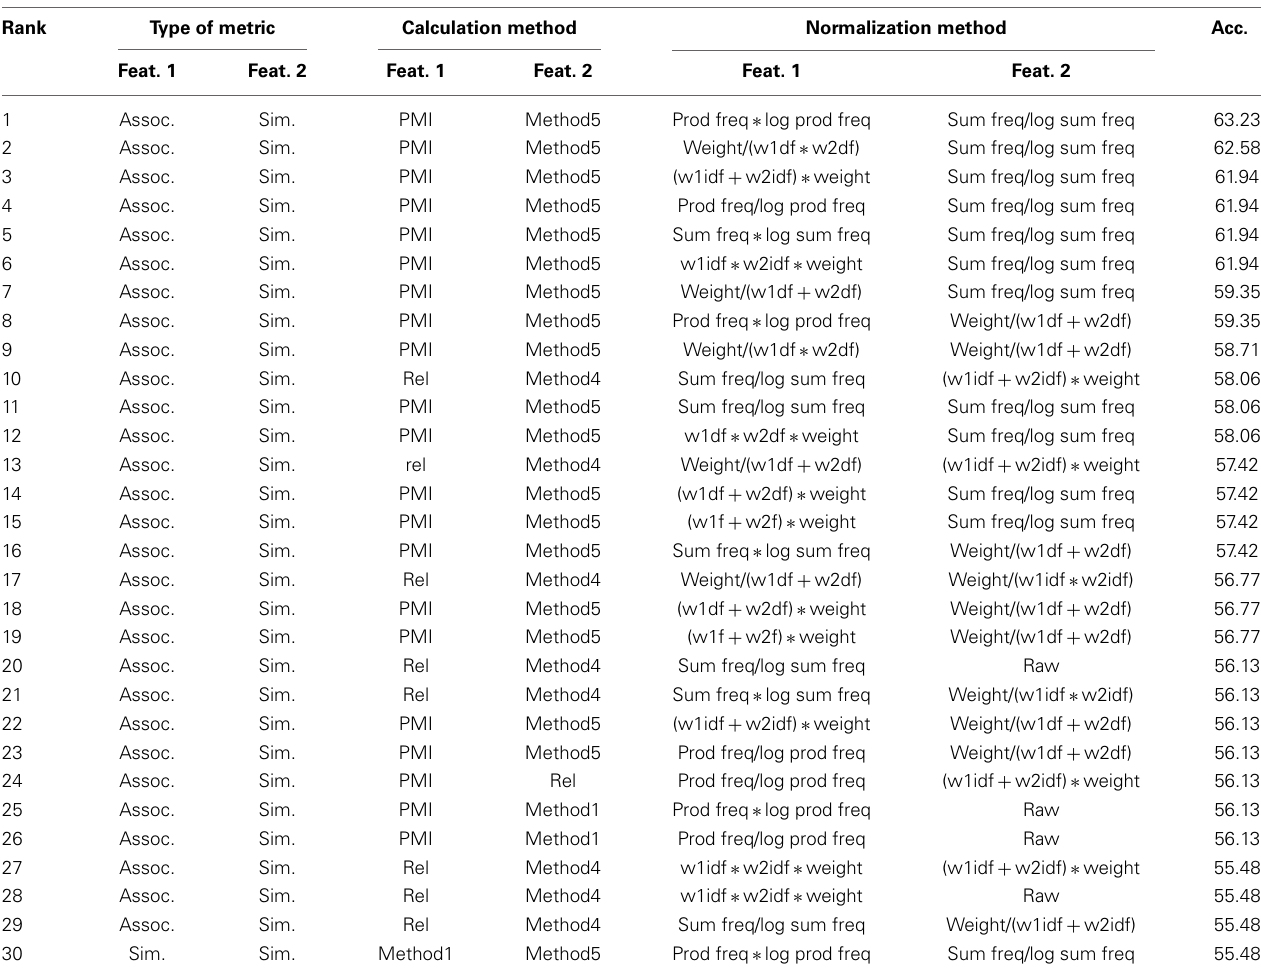
Table 6 | Methods and accuracy of the top 30 pairs of features described